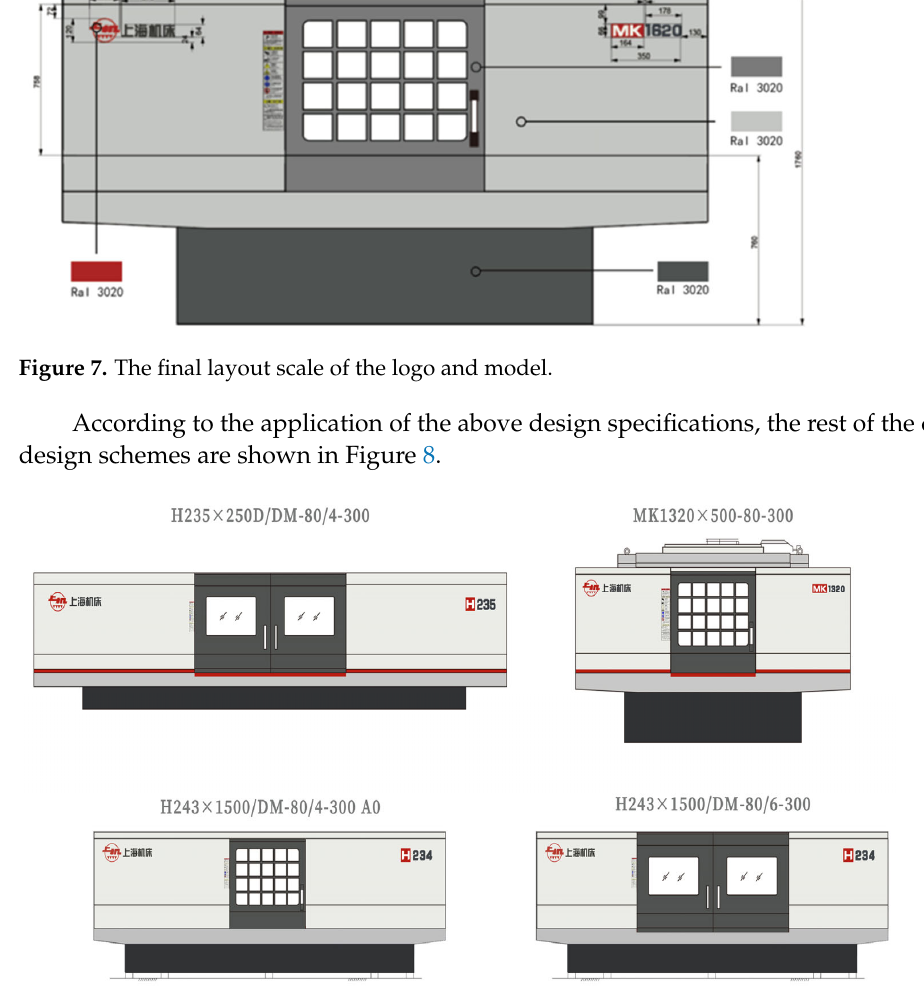
Figure 8. Display of the coating design schemes of some machine tool series.